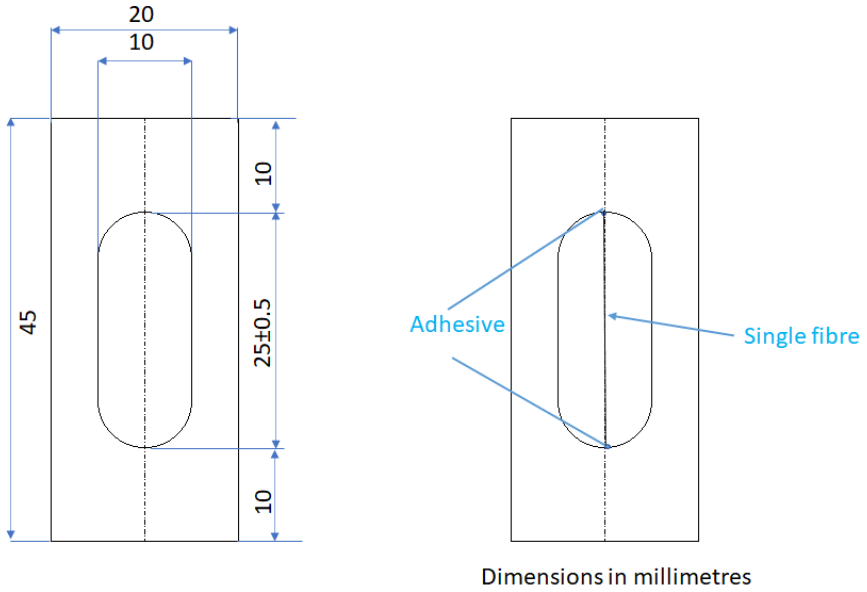
Figure A1. Tensile test setup for melt spun extrusion dwell time MP/PE fibre using a DEBEN Microtest fibre tensile tester and a Leica EC4 microscope.